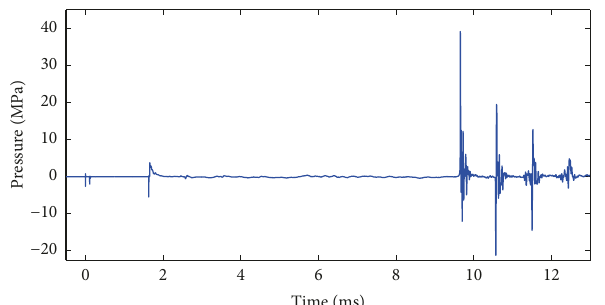
Figure 11: Pressure-time profile recorded by HPB with a 3mm